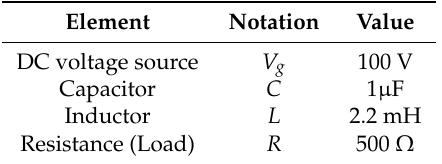
Figure 3. Frequency response of the transfer function of Buck converter described by (4) with parameter values of Table 1. Table 1. Component values of Buck converter from Figure